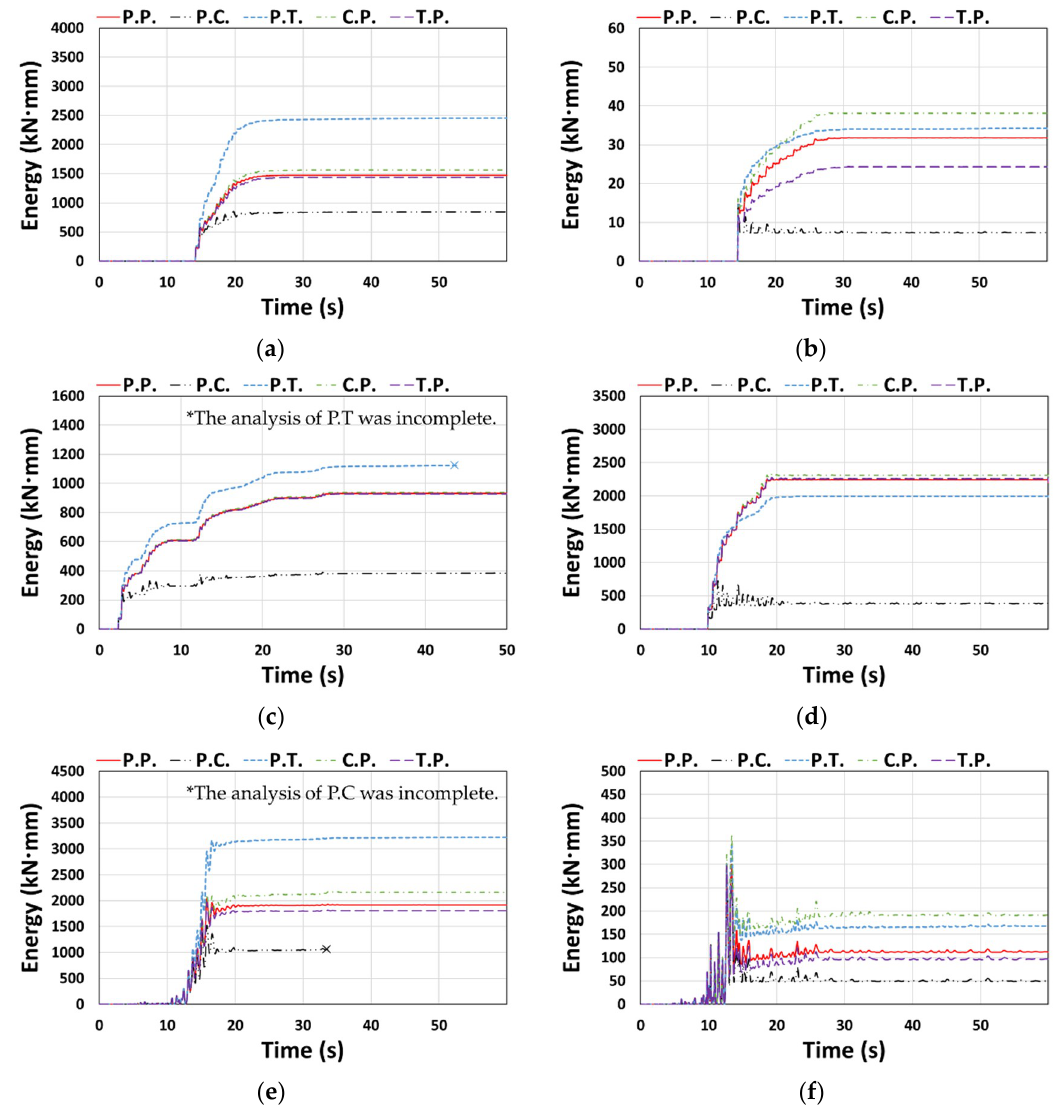
Figure 13. Cumulative dissipated energy: ( a ) Type 1 (Northridge, X-dir.), ( b ) Type 1 (Northridge, Y-dir.), ( c ) Type 2 (El Centro, X-dir.), ( d ) Type 2 (Northridge, Y-dir.), ( e ) Type 3 (Northridge, X-dir.), and ( f ) Type 3 (Northridge, Y-dir.).